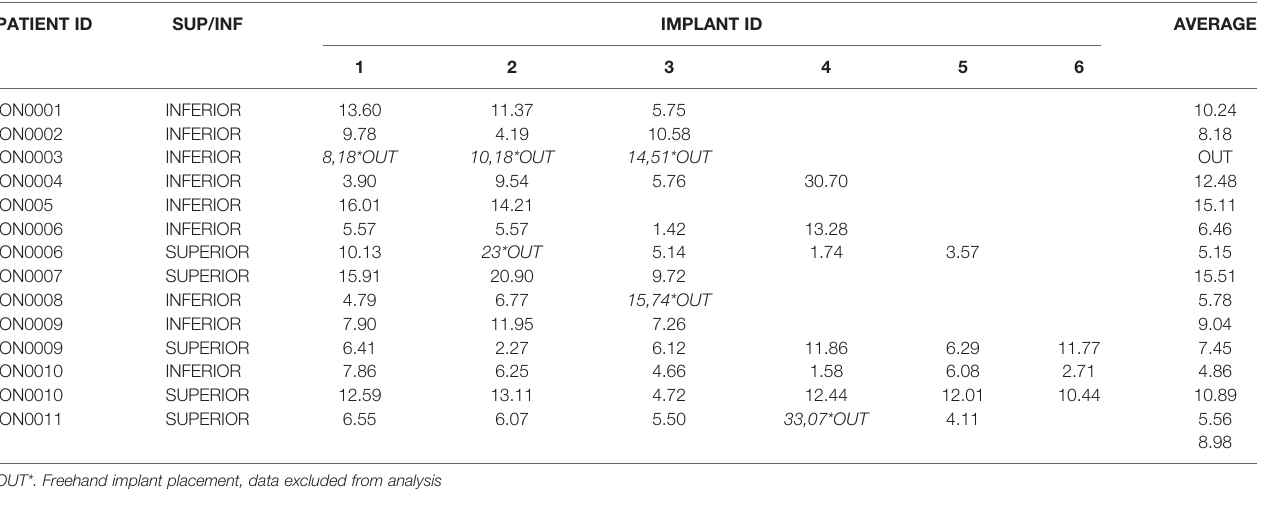
TABLE 4 | Results of the angular deviation in